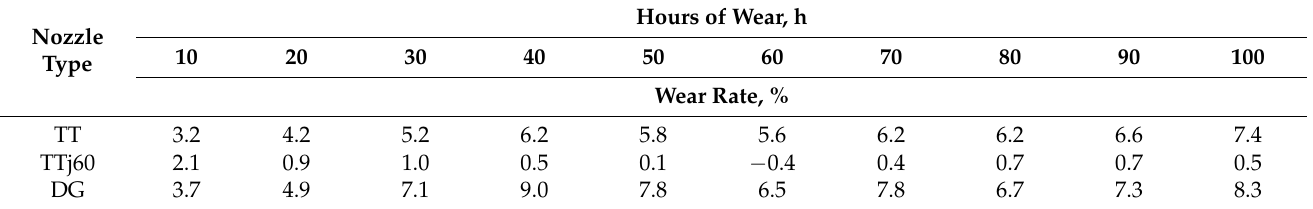
Table 2. The wear rate (%) during the different wear periods for the three types of nozzles.